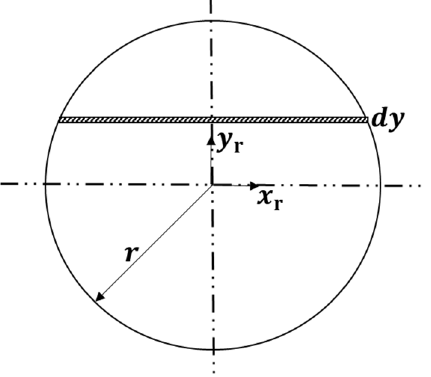
Figure 5. Cross-section diagram of flexible airbag.